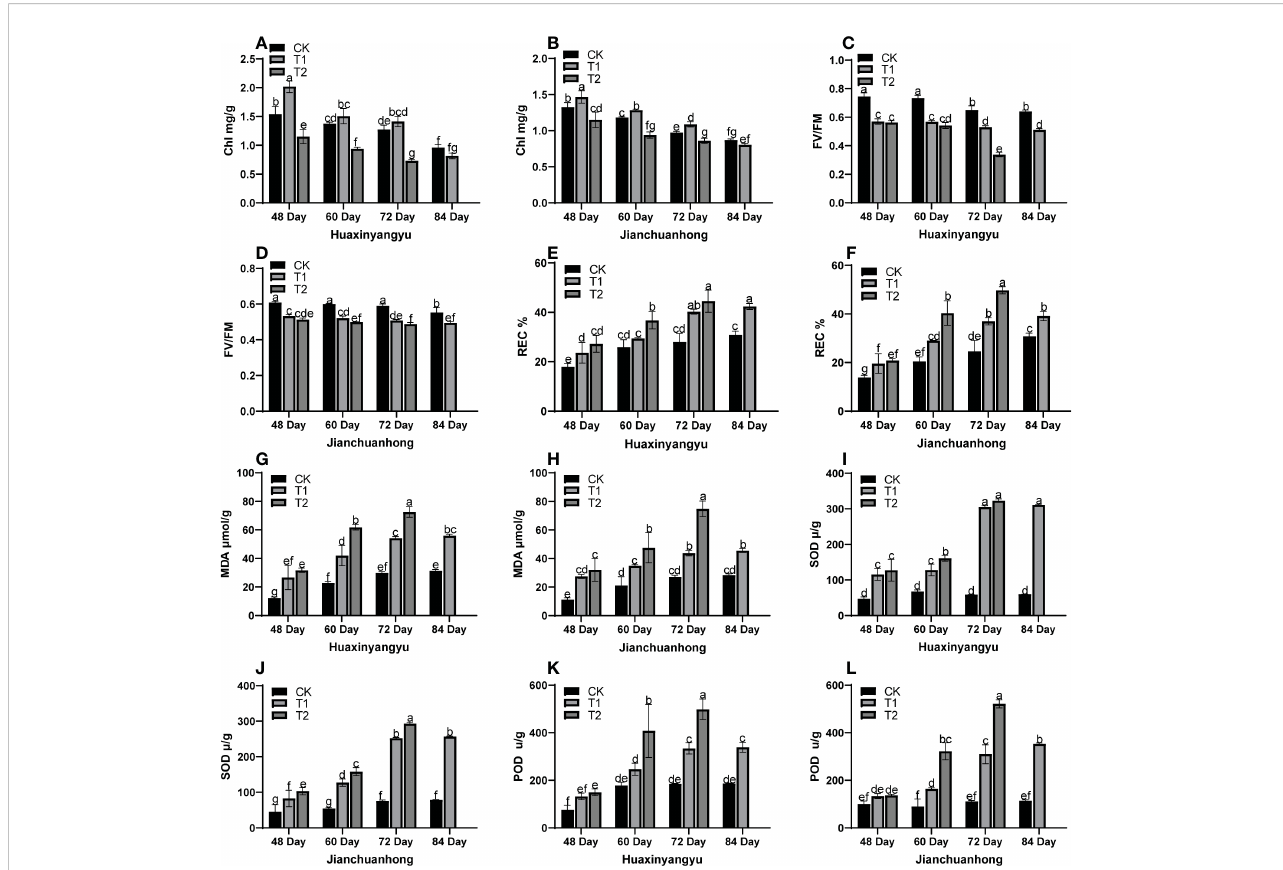
FIGURE 2 Analysis of stress physiological indexes of leaves of different UV-B treatments in the whole growth period of “ Huaxinyangyu ” and “ Jianchuanhong ” . (A) the chlorophyll content (Chl) of “ Huaxinyangyu “ , (B) Chlorophyll content (Chl) of “ Jianchuanhong “ , (C) Chlorophyll fl uorescence parameter (FV/FM) of “ Huaxinyangyu ” , (D) Chlorophyll fl uorescence parameter (FV/FM) of “ Jianchuanhong ” , (E) the relative permeability (REC%) of “ Huaxinyangyu ” , (F) the relative permeability (REC%) of “ Jianchuanhong ” , (G) the malondialdehyde (MDA) of “ Huaxinyangyu ” , (H) the malondialdehyde (MDA) of ” Jianchuanhong ” , (I) the superoxide dismutase (SOD) of “ Huaxinyangyu ” , (J) the superoxide dismutase (SOD) of “ Jianchuanhong ” , (K) the determination of peroxidase (POD) of “ Huaxinyangyu ” , (L) the determination of peroxidase (POD) of “ Jianchuanhong ” . (According to the Duncan test, different letters indicate a signi fi cant difference (p< 0.05) among the treatments. The error bars represent the mean ± SE. The x-axis represents the variety of names, and the Y axis represents compound